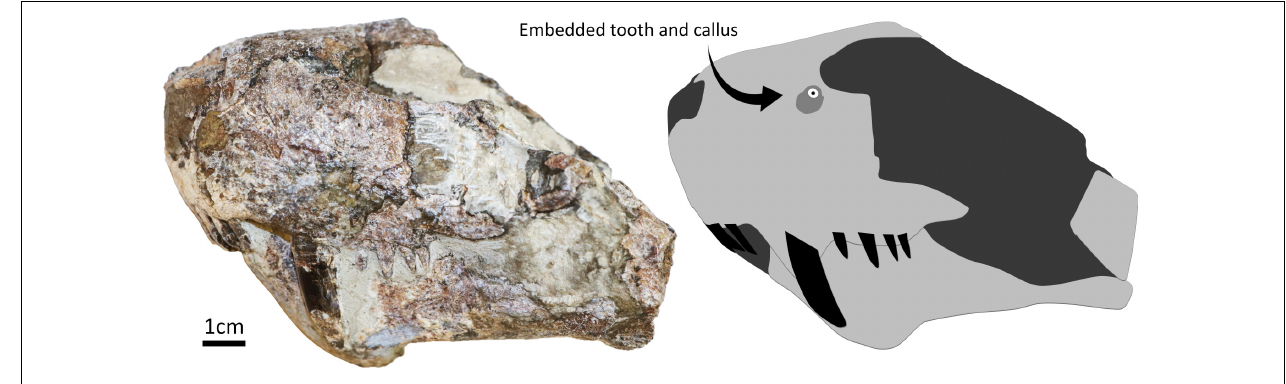
FIGURE 1 | Specimen SAM-PK-11490 in left lateral with a simplified diagram showing the position of the embedded tooth and surrounding